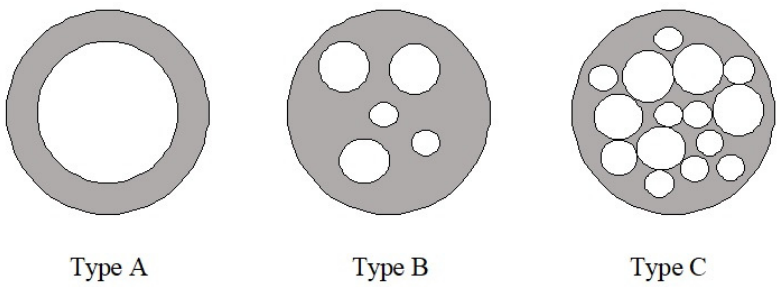
Figure 4. Classification of types of emulsions according to the distribution of the oil phase.